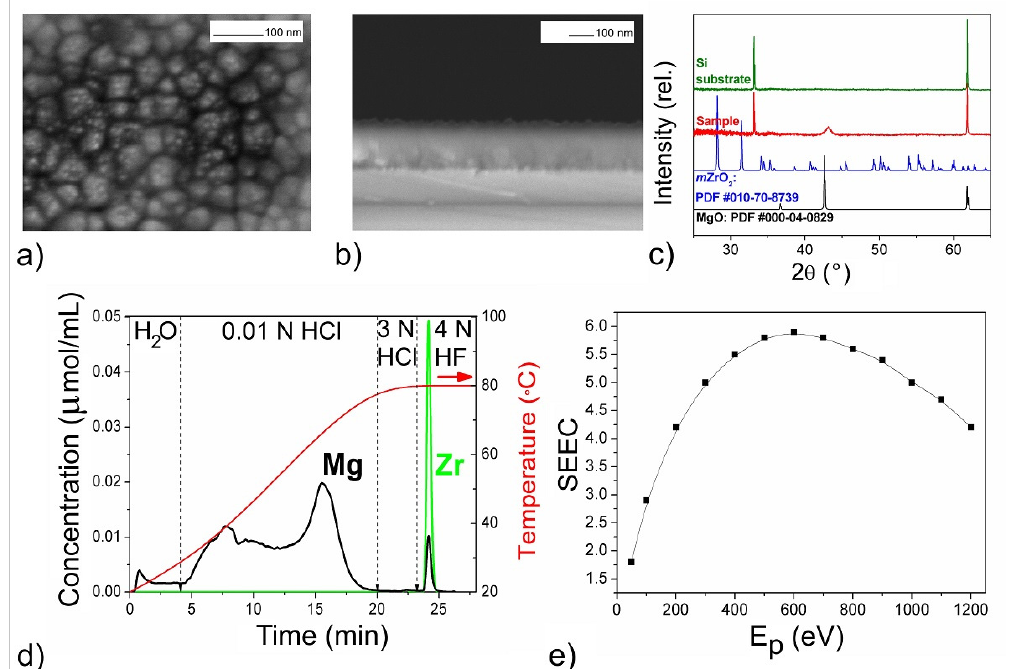
Figure 6. The mixed oxide film with n(Mg):n(Zr) = 10:1 according to DD data: SEM images ( a , b ), XRD pattern ( c ) DD curves ( d ), SEEC (Ep) curves ( e ).